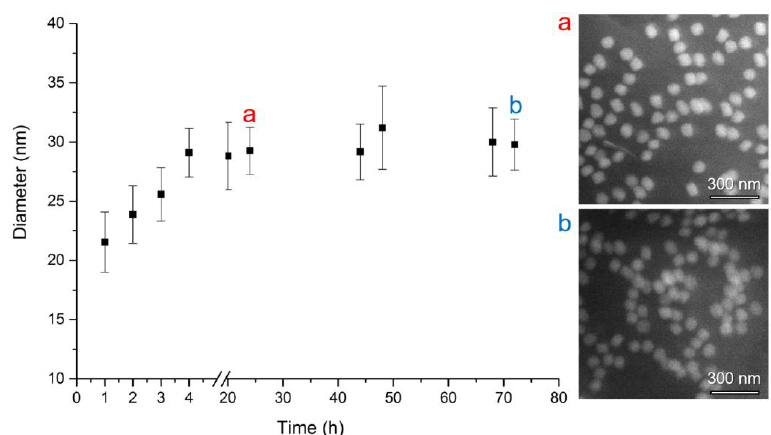
Figure 3. Dependence of CdTe/SiO 2 QDs average hydrodynamic particle diameter (nm) on time (hours) of silica shell growth. The number of Dynamic Light Scattering (DLS) measurements per one exposure time was 5, error bars correspond to standard deviations. Scanning Electron Microscopy (SEM) photograh ( a ) after 24 h growth (diameter 53.7 ± 4.2 nm) and ( b ) after 72 h growth (diameter 59.7 ± 4.0 nm).